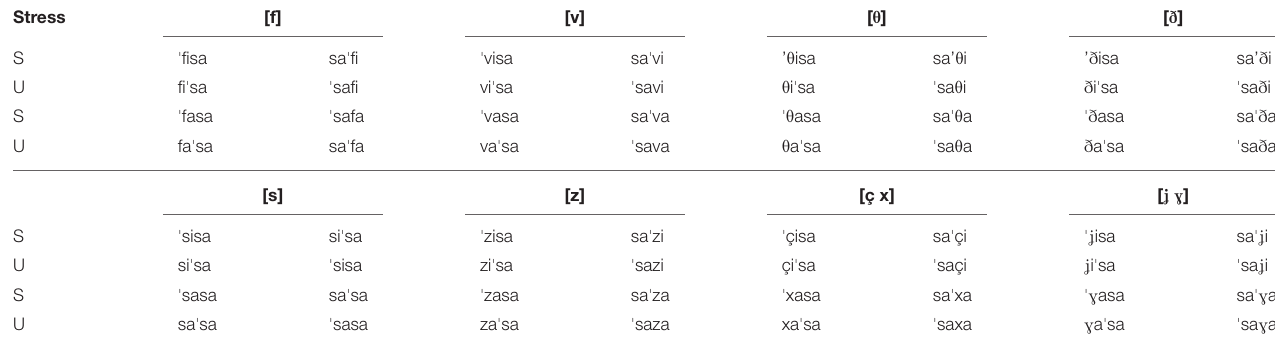
TABLE 2 | Experimental material.